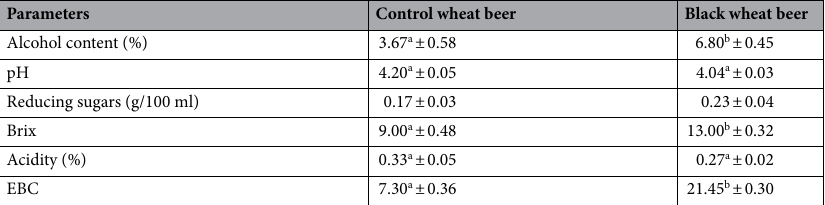
Table 2. Physicochemical attributes of beer produced from control wheat and black wheat. EBC color determined by European brewing convention units at 430 nm. Values are mean of three replicates ± standard deviation (p < 0.05). Values with different superscript roman letters (a and b) in the same column are significantly different according to the Tukey’s range test (p < 0.05).